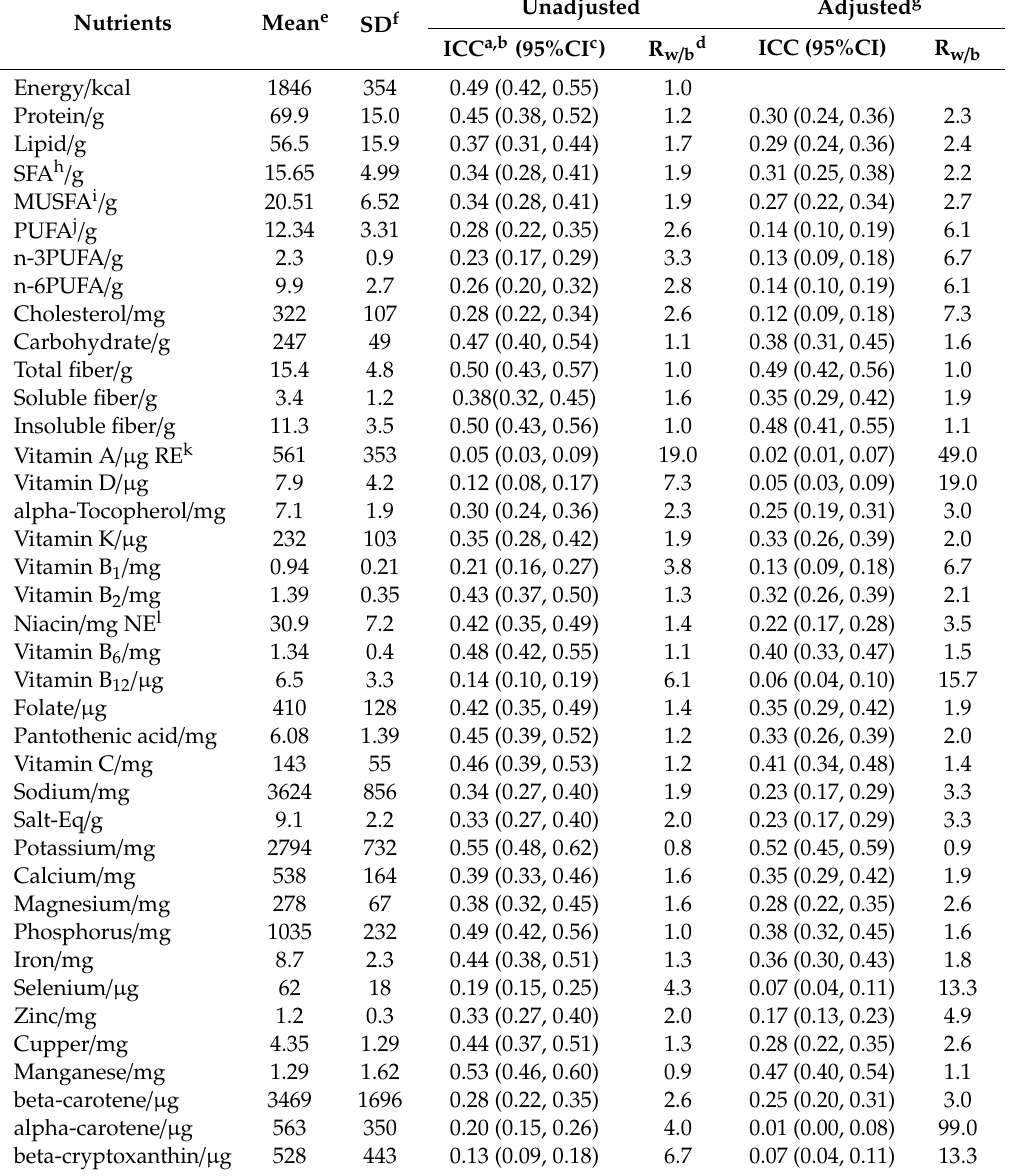
Table 1. Intraclass correlation coe ffi cients (ICC) and the ratio of within- to between-person variance (Rw / b) for daily intakes of unadjusted- and adjusted-nutrients (data provided by 131 residents in